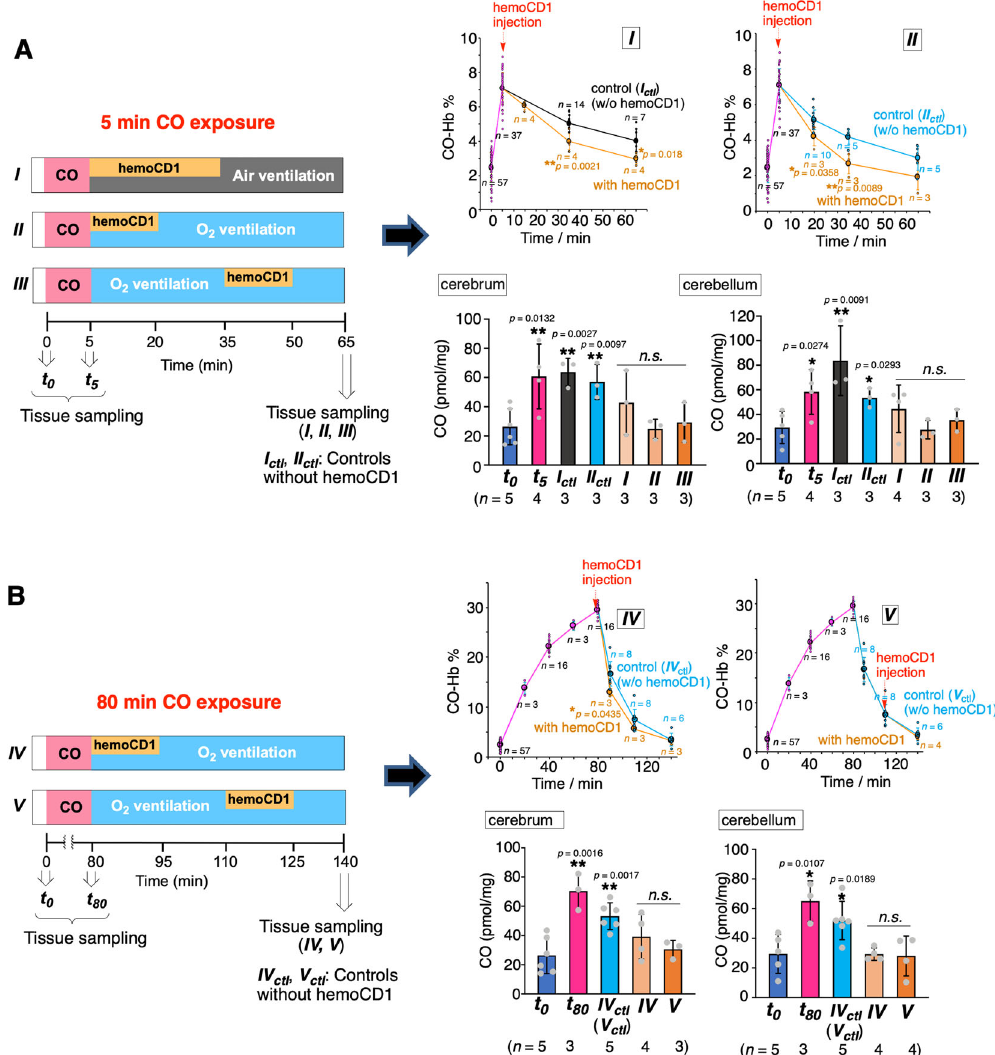
Fig. 7 Effect of normobaric air/O 2 ventilation in combination with hemoCD1 injection on CO levels in blood and tissues after exposure to exogenous CO in rats. A Anesthetized rats were exposed to CO inhalation (400 ppm) for 5 min followed by either air or pure O 2 ventilation in combination with intravenous hemoCD1 infusion (1.4 ± 0.2 mM, 2.5 ml in PBS) as indicated by the three different protocols: I , oxy-hemoCD1 was infused for 30 min under room air ventilation; II : oxy-hemoCD1 was infused for 15 min under pure O 2 ventilation; III : O 2 ventilation was conducted for 30 min before infusion of oxy- hemoCD1 for 15 min. The right panels show the changes in CO-Hb (%) of the blood and the CO levels detected in the cerebrum and cerebellum samples collected as indicated. B Anesthetized rats were exposed to CO inhalation (400 ppm) for 80 min followed by O 2 ventilation in combination with intravenous hemoCD1 infusion (3.0 ± 0.2 mM, 2.5 ml in PBS) as indicated by the two different protocols: IV , oxy-hemoCD1 was infused for 15 min under pure O 2 ventilation; V : O 2 ventilation was conducted for 30 min before infusion of oxy-hemoCD1 for 15 min. The right panels show the changes in CO-Hb (%) in the blood and the CO levels detected in the cerebrum and cerebellum samples collected as indicated. Each plot for CO-Hb (%) represents mean ± SD ( n > 3, the numbers of experiments are shown in the panels). Each bar for CO (pmol/mg) represents the mean ± SD ( n > 3, the numbers of experiments are shown in the panels). Statistical signi fi cance, * p < 0.05, ** p < 0.01; n.s. not signi fi cant versus t 0